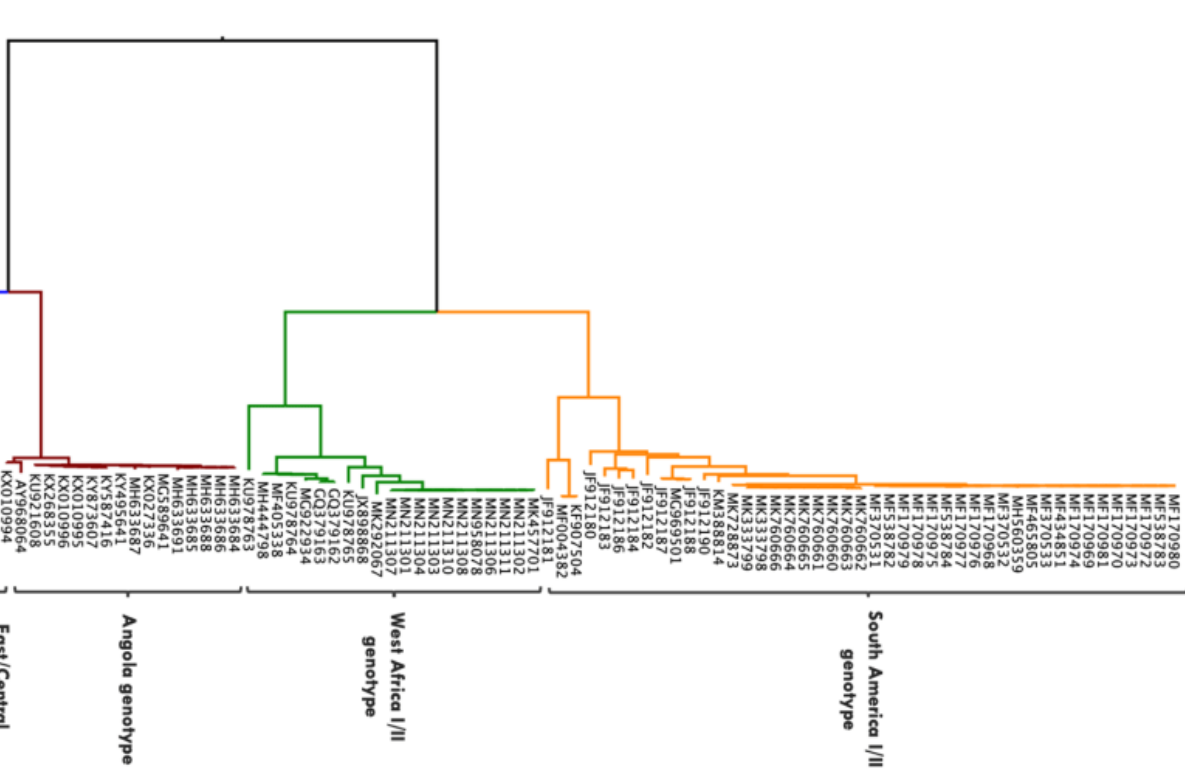
Figure 2. Phylogenetic tree showing 86 complete genome sequences of YFV isolated from biological samples obtained from human beings. Sequences obtained from Virus Pathogen Resource (https://www.viprbrc.org accessed on 26 May 2021). Maximum likelihood phylogenetic tree generated in IQ-TREE using the general time reversible nucleotide substitution model with gamma-distributed among-site rate variation (GTR + G) [20]. Phylogenetic tree rooted and visualised using FigTree program (http://tree.bio.ed.ac.uk/software/figtree/ accessed on 26 May 2021).